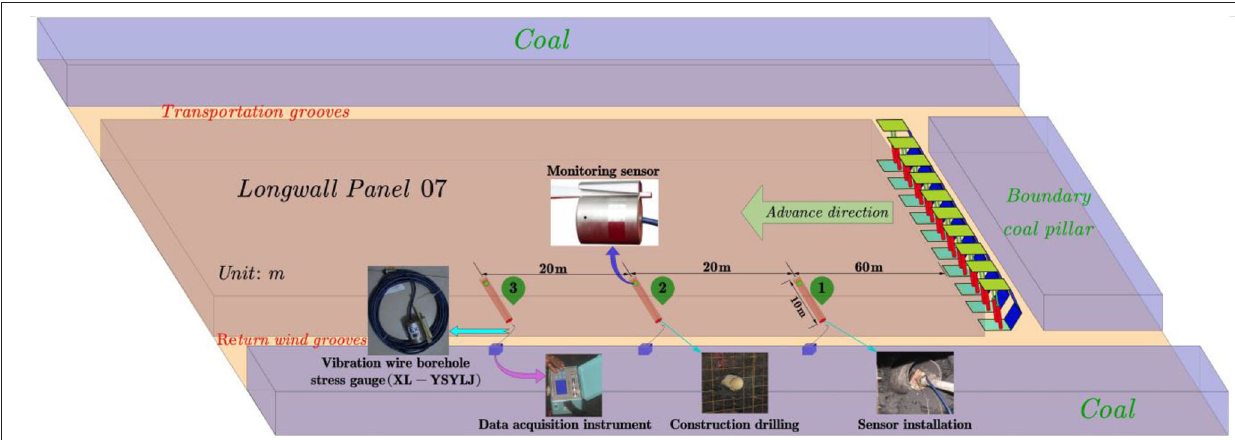
FIGURE 11 | Layout diagram of actual measurement of coal pillar advance bearing